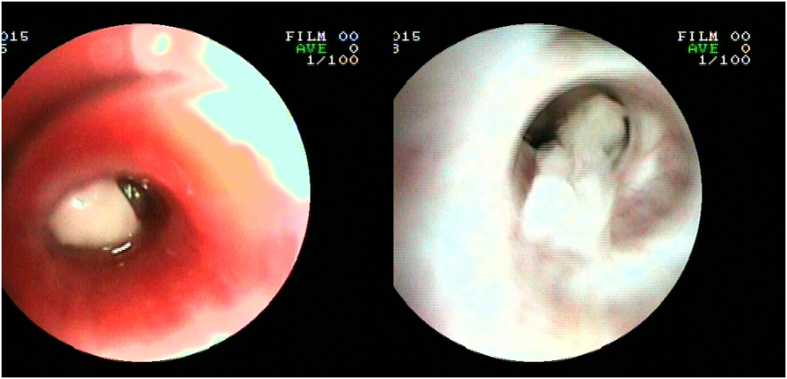
Bronchoscopic findings of the patient with mucus plug formation.